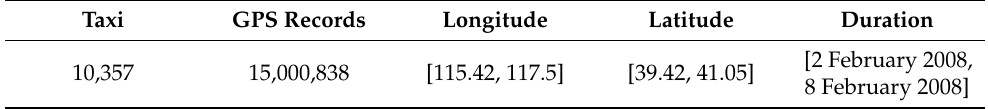
Table 1. Beijing taxi data set.